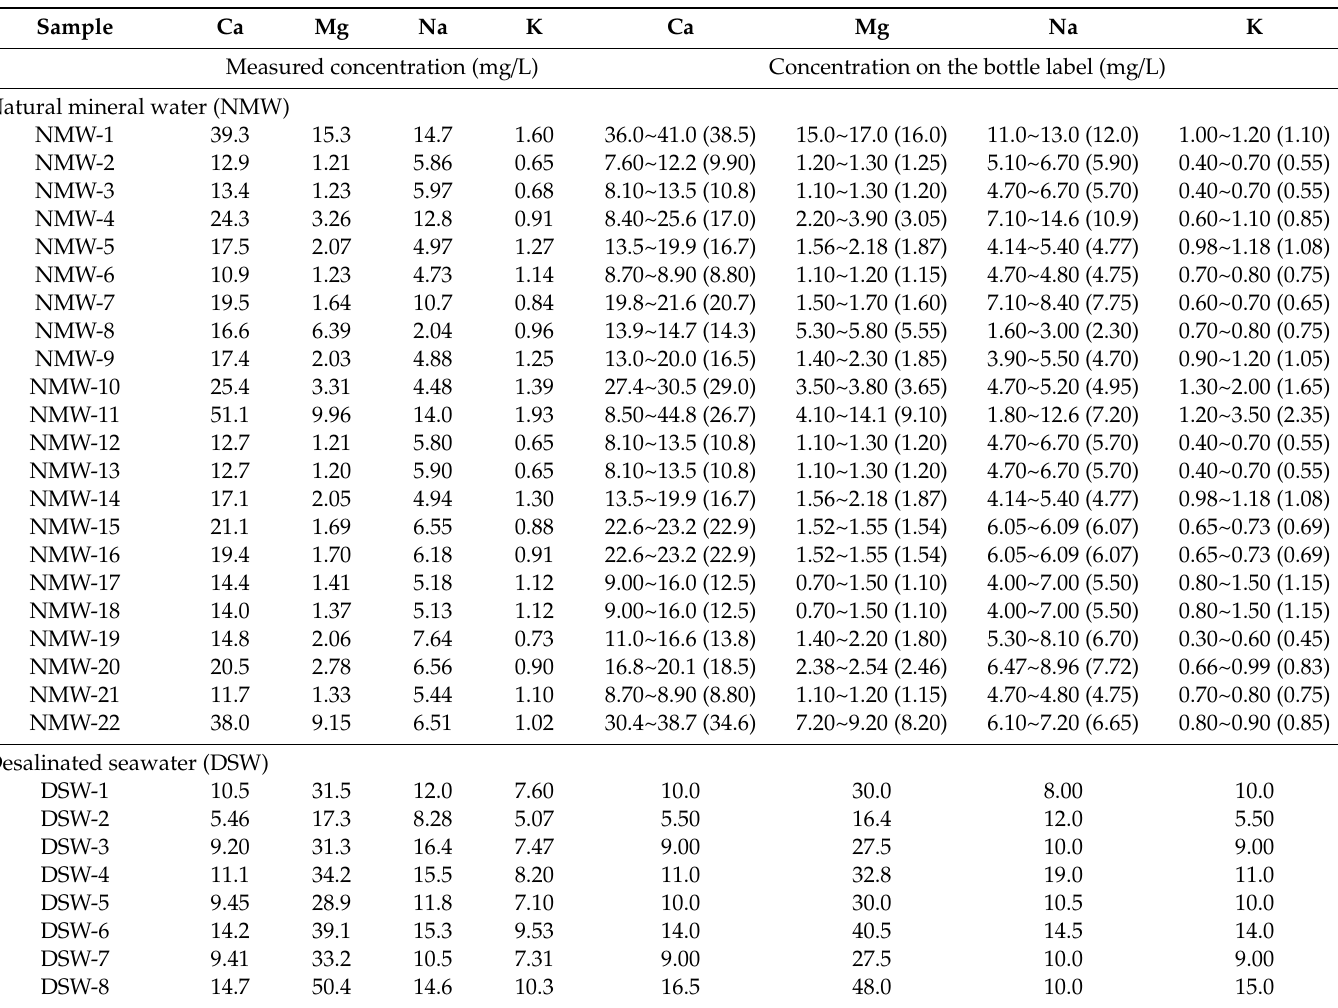
Table 2. Major cation contents measured for natural mineral water and deep-sea drinking water collected in this study and described on bottle